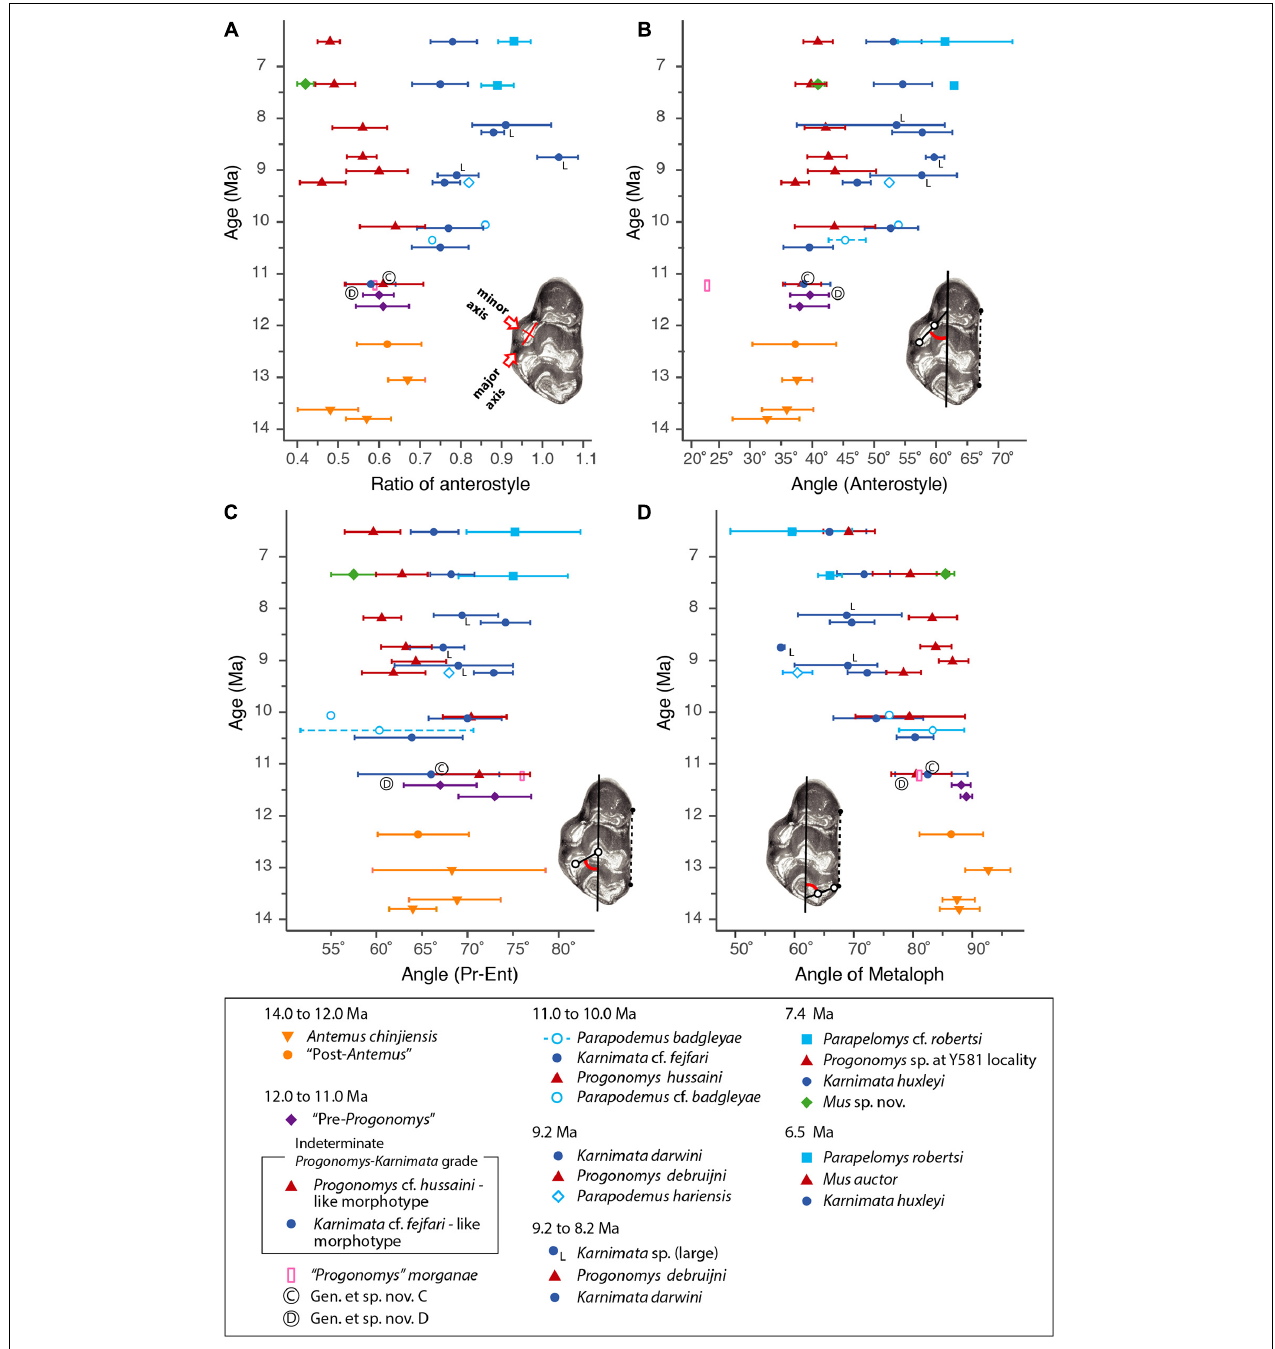
FIGURE 3 | Temporal change and variation in four morphometric characters in Siwalik murines. (A) Axis ratio of anterostyle shape (length of the minor axis relative to that of the major axis). (B) Acute angle between the anterostyle and the longitudinal axis of the tooth. (C) Acute angle formed by a line connecting the centers of protocone and enterostyle with the longitudinal axis of the tooth. (D) Acute angle between the major axis of the metacone (forms a metaloph with the hypocone) and the longitudinal axis of the tooth. Error bars indicate 95% bootstrap confidence intervals. The specimen illustrated is Progonomys debruijni (YGSP 7740) in early wear. Versions of panels (A–C) initially in Kimura et al. (2013b), updated here with revised taxonomy; panel (D) is new. Error bars represent 95% confidence intervals.